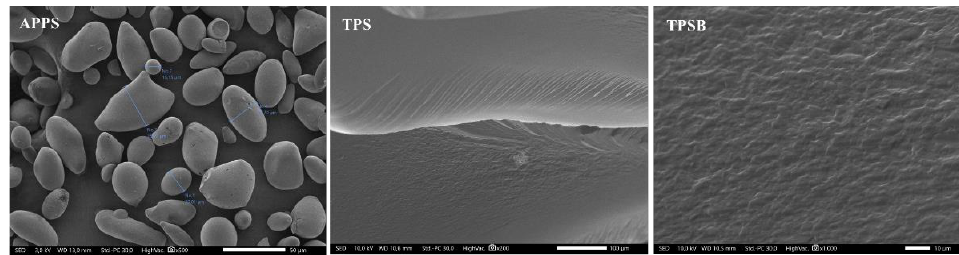
Figure 3. Surface morphology of APPS and cross-section morphology of TPS and TPSB.